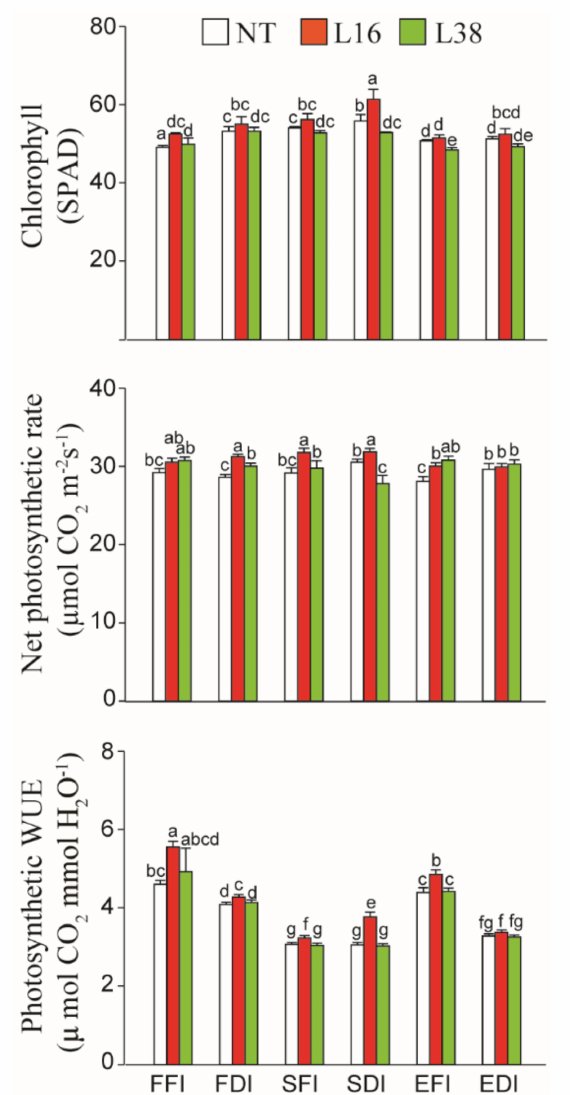
Figure 4. Effects of treatments on the photosynthetic rate, chlorophyll content and IWUE of cotton in July 2017 and 2018. Full forecast irrigation (FFI); 75% of full forecast irrigation (FDI); full soil moisture irrigation (SFI); 75% of full soil moisture irrigation (SDI); full flood irrigation (EFI); 75% of full flood irrigation (EDI). Different letters indicate significant differences between transgenic lines and NT following Duncan’s multiple range tests at the 5% level of